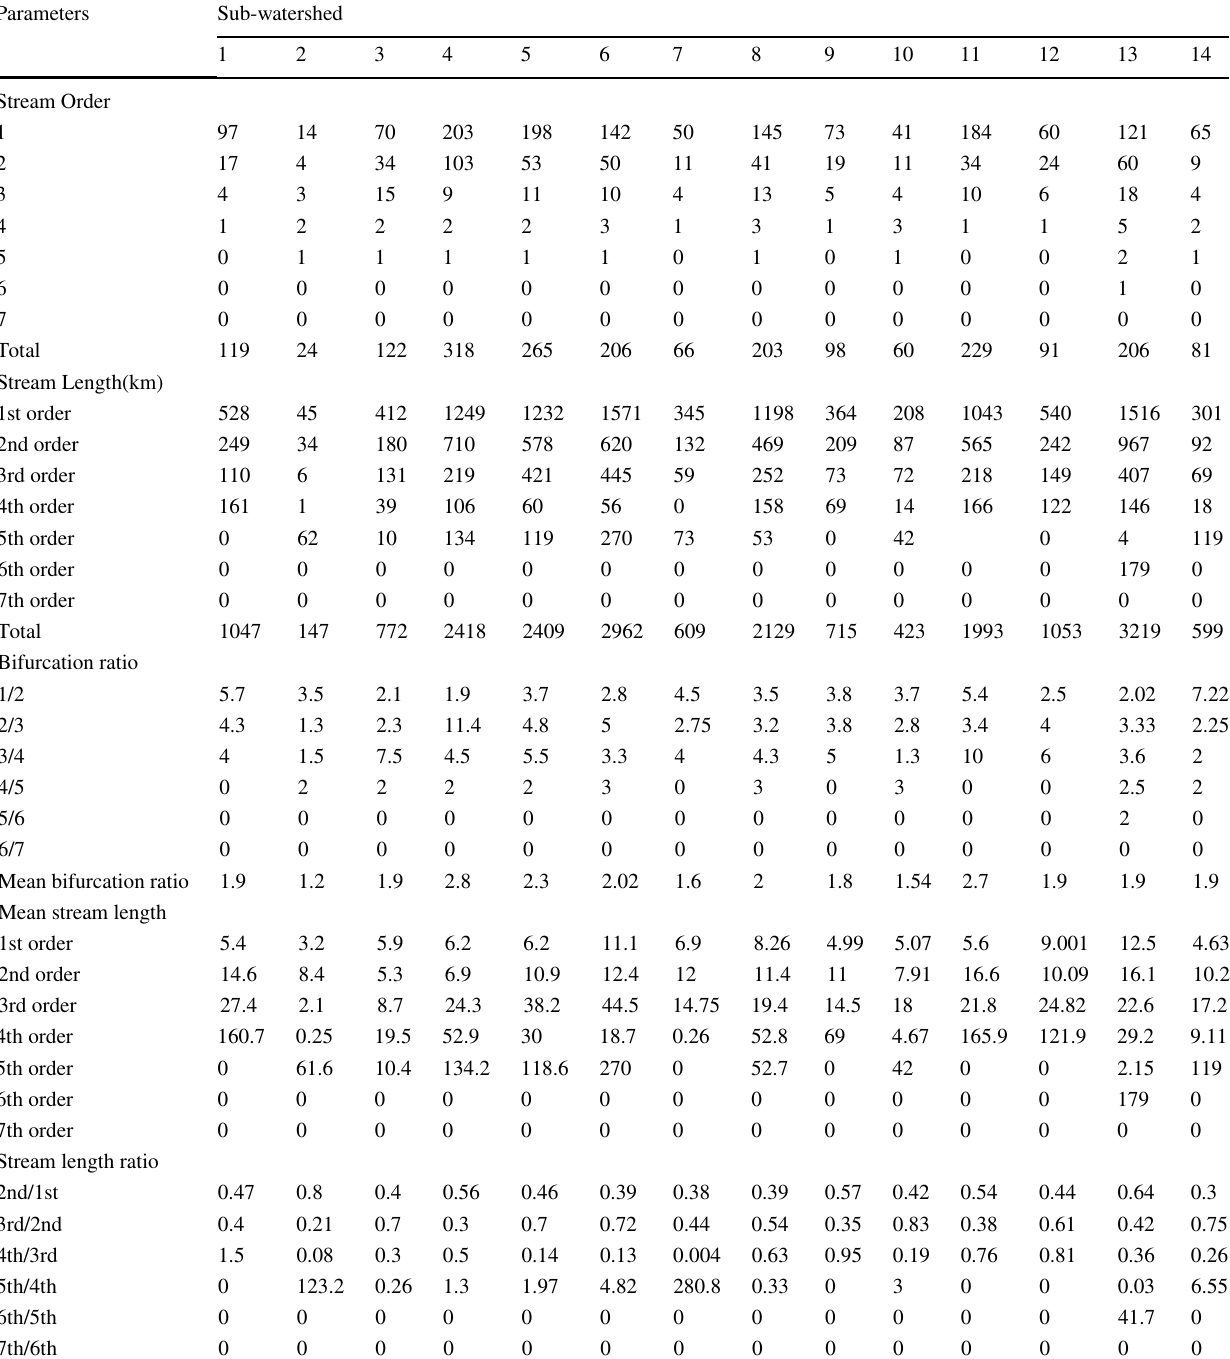
Table 5 a Linear morphometric parameters of Upper Benue River Watershed, b linear morphometric parameters of Upper Benue River Water-